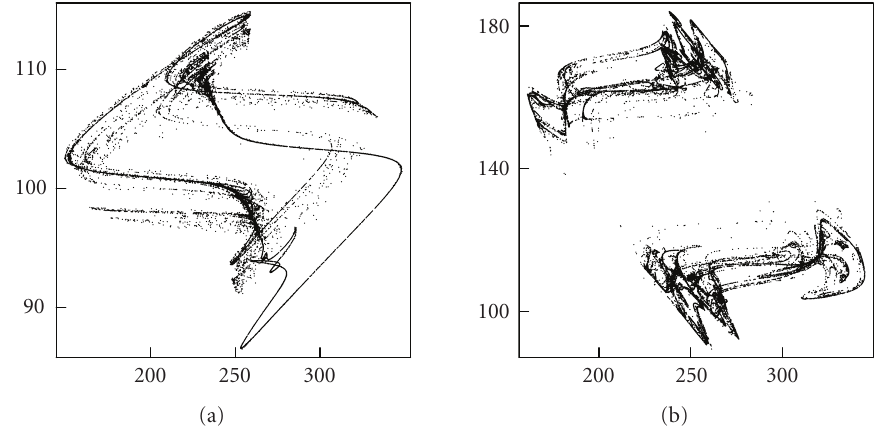
Figure 6.3. Ten-piece attractor for β = 1 . 8, α = 1 . 045.